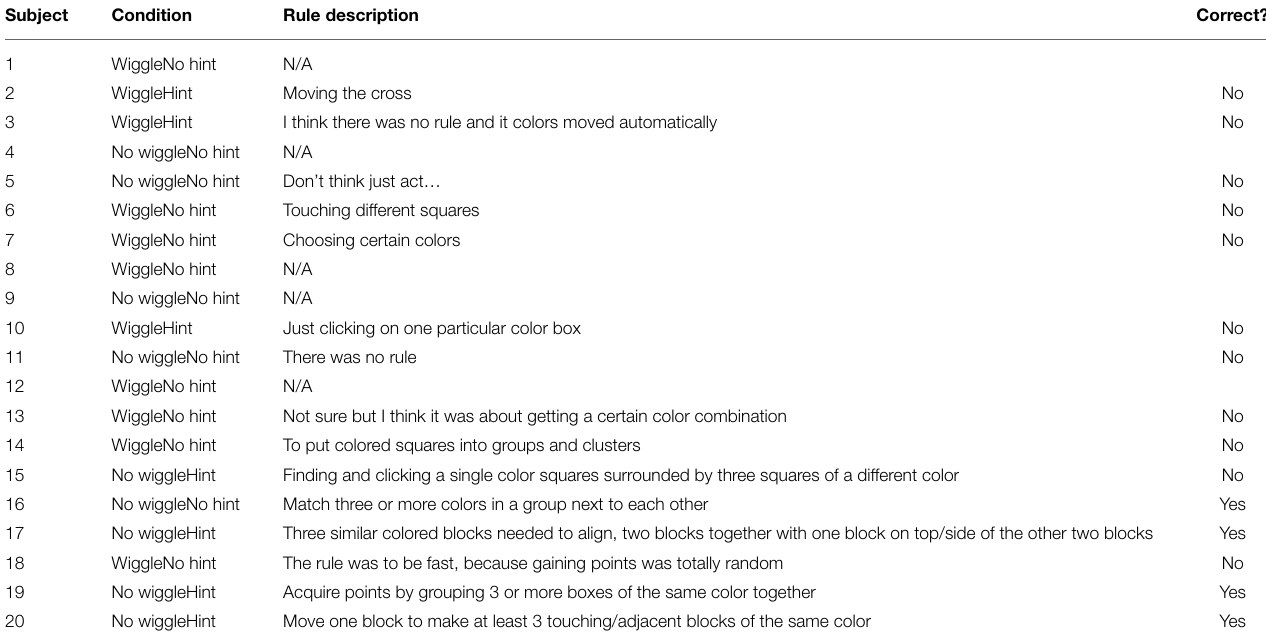
TABLE 2 | Verbatim self-reported rule descriptions following Session 1 of game play, by